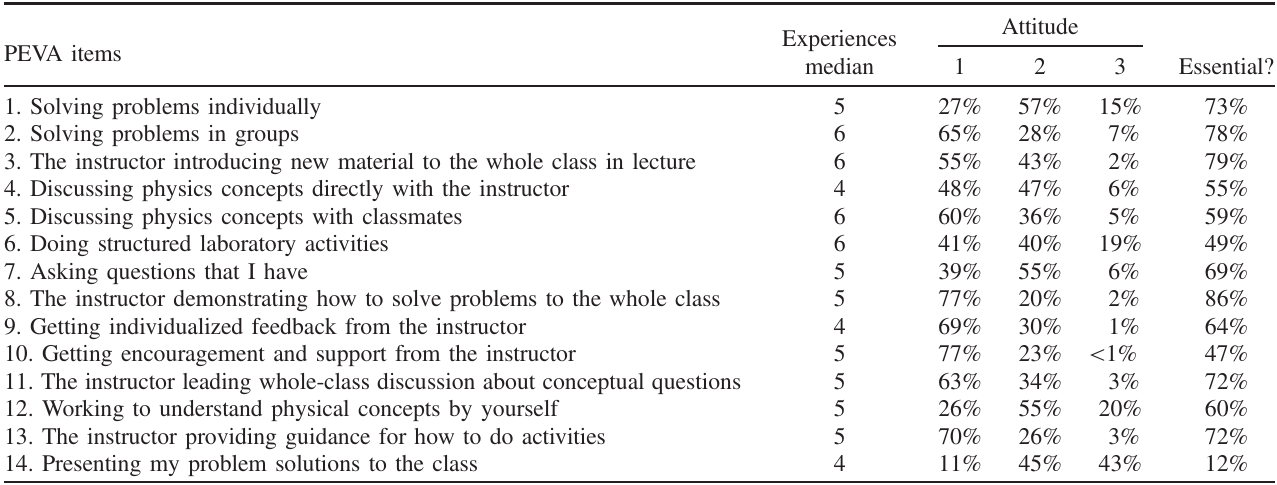
TABLE VI. Students ( N ¼ 176 ) reported their experiences at week 14 about how frequently certain activities occurred in the classroom (a rating of 7 means, almost constantly; a rating of 1 means, almost never), their attitude toward those activities (1 means, it is enjoyable; 2 means, I don ’ t enjoy it but I don ’ t mind it; 3 means, I do not enjoy it and I don ’ t like when we do it), and whether they feel those activities are essential (reported is the percent of respondents to the attitude survey selecting the activity as